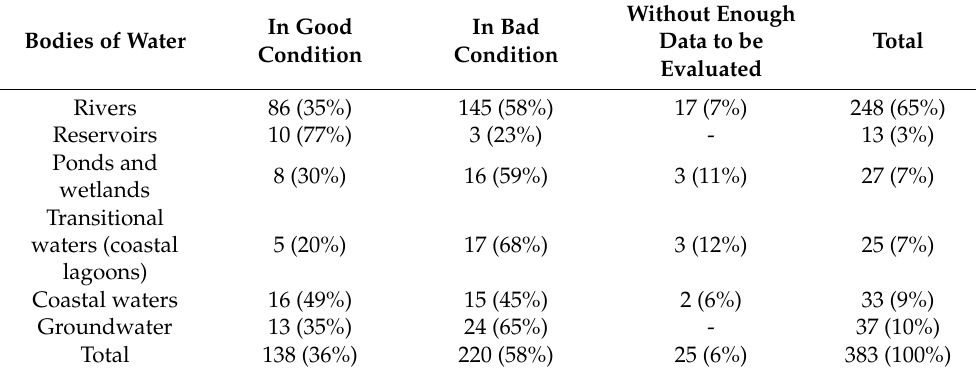
Table 15. Number and percentage of bodies of water in the Catalonia River Basin District. Evaluated in accordance with the protocols and metrics required by the Water Framework Directive (2000/60/EC)